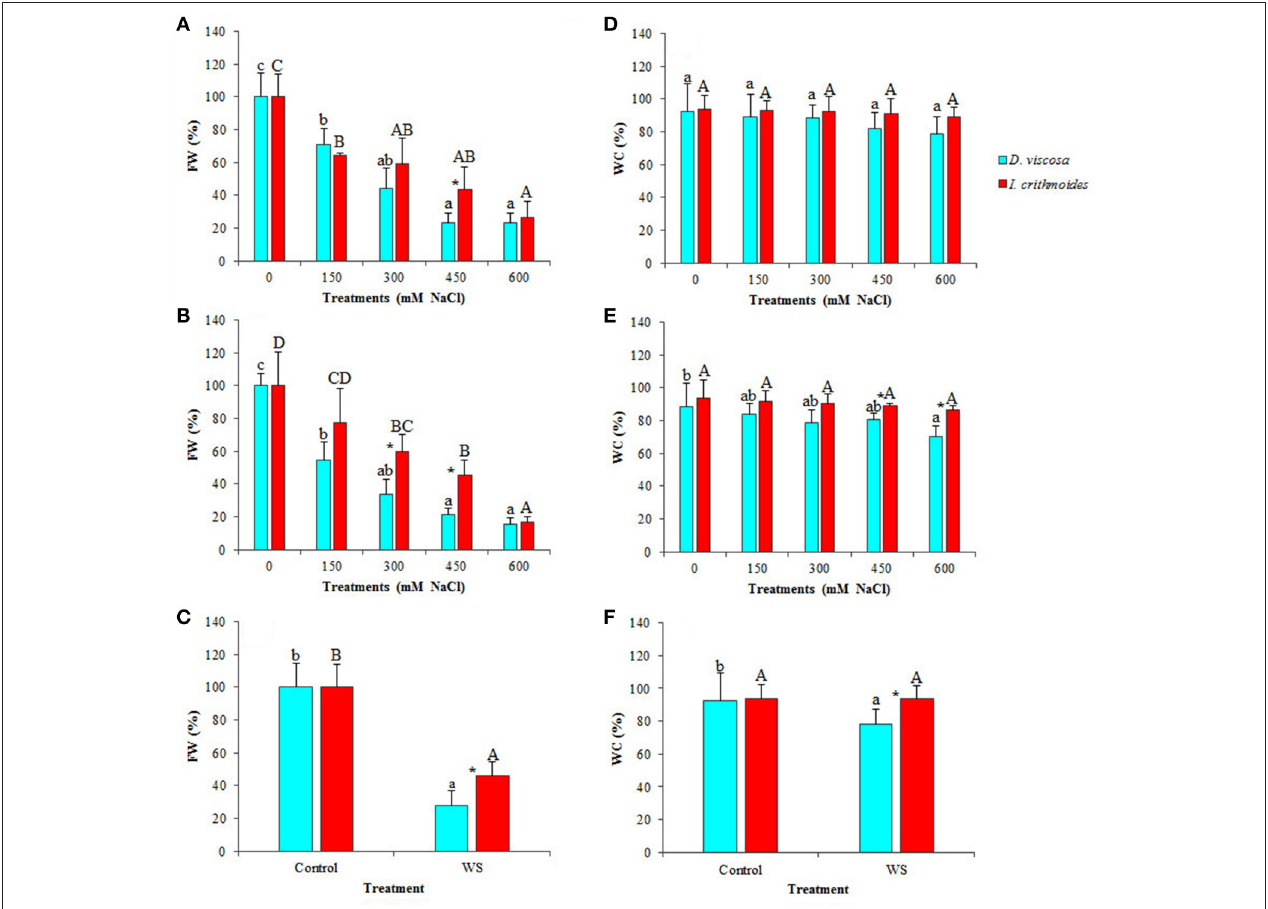
FIGURE 3 | Stress-induced growth inhibition in Dittrichia viscosa and Inula crithmoides . Leaf fresh weight [FW(%)] (A–C) and water content [WC(%)] (D–F) after 3 (A,D) and 6 (B,E) weeks of treatment with the indicated NaCl concentrations, or after 3 weeks of water stress (C,F) . For each treatment, FW is expressed as percentage of the absolute weight of the corresponding non-treated control, taken as 100%: 10.85 and 24.40g for D. viscosa and 11.11 and 19.99g for I. crithmoides , at 3 and 6 weeks of growth, respectively. Values shown are means ± SD ( n = 5 ). Different letters (lowercase for D. viscosa and capital letters for I. crithmoides ) over the bars indicate significant differences between treatments for each species according to Tukey test ( α = 0.05). Asterisks ( * ) indicate significant differences between the two species for the same